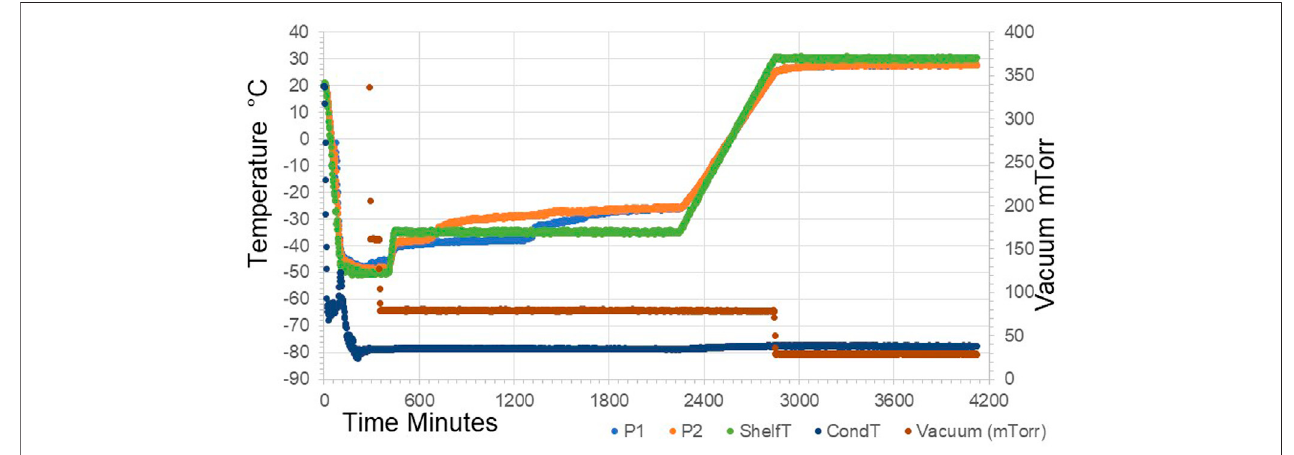
FIGURE 2 | Freeze-drying pro fi le of SS-889 trial with (P1) and without (P2) additional NaCl in formulation.